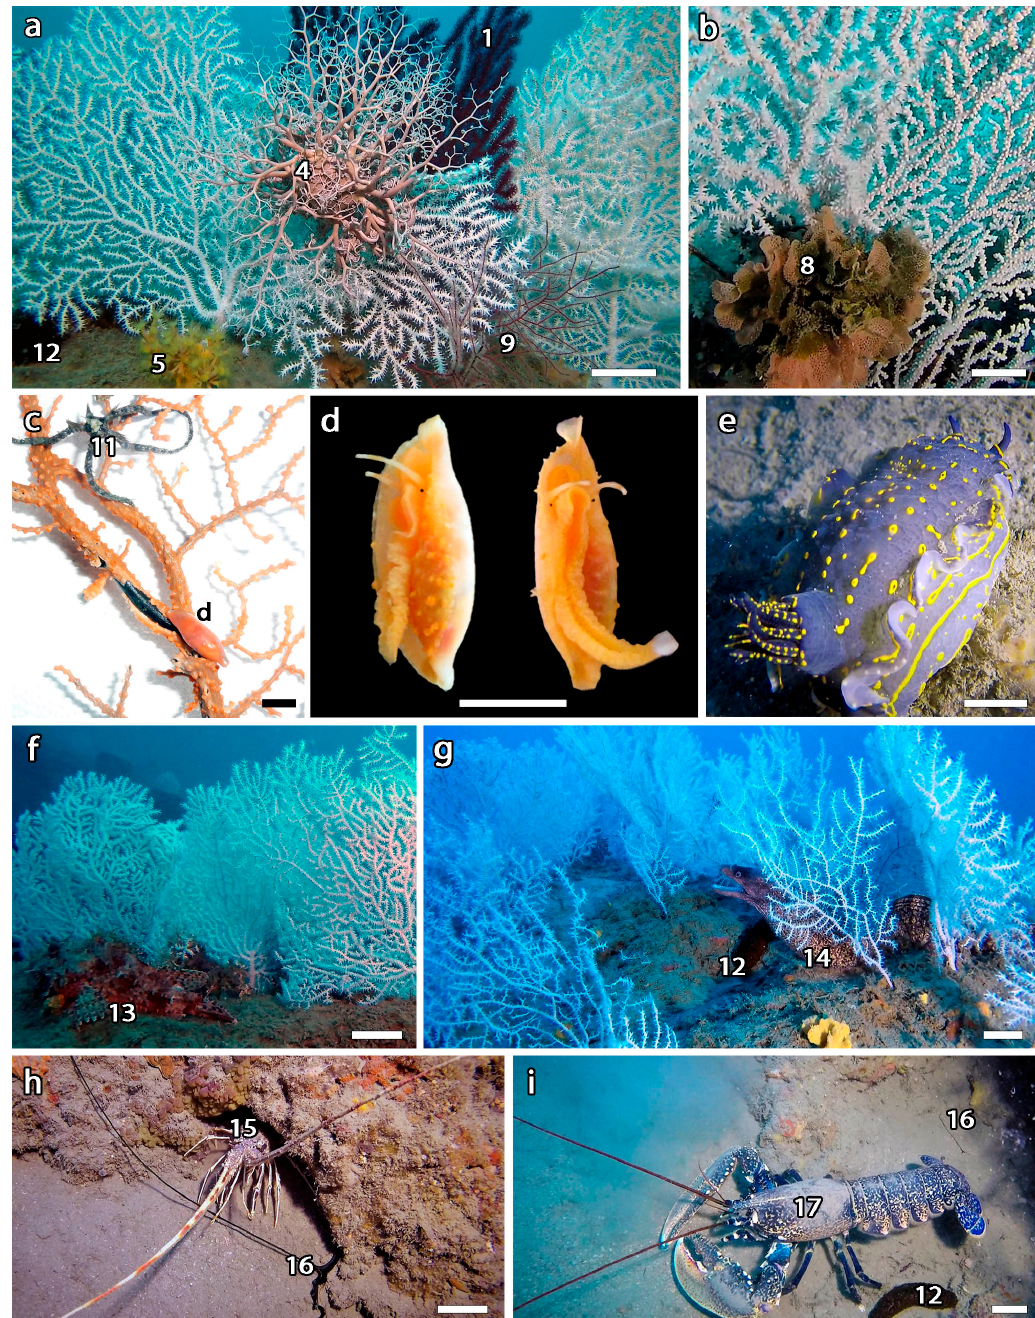
Figure 6. Examples of the animal taxa associated with Eunicella verrucosa . ( a ) Colonies of E. verrucosa with Paramuricea clavata (1) in the background, Leptogorgia sarmentosa (9), Astrospartus mediterraneus (4), Axinella sp. with Parazoanthus axinellae (5), and Holothuria sp. (12); ( b ) colonies of the bryozoan Reteporella cf. grimaldii (8) as epibiont on E. verrucosa ; ( c ) sample of E. verrucosa with the ophiuroid Ophiacantha setosa (11) and the gastropod Simnia spelta ; ( d ) lateral (left) and ventral (right) view of S. spelta ; ( e ) the nudibranch Felimare picta crawling on the hard bottom below the E. verrucosa forest; ( f ) the red scorpionfish Scorpaena scrofa (13); ( g ) the Mediterranean moray eel Muraena helena (14); ( h ) the spiny lobster Palinurus elephas (15) and the echiurid Bonnellia viridis (16); ( i ) a large specimen of the European lobster Homarus gammarus (17) with Holothuria sp. (12) and B. viridis (16). Scale bars: a–b,f–g, 5 cm; c–e, 1 cm; h–I, 10